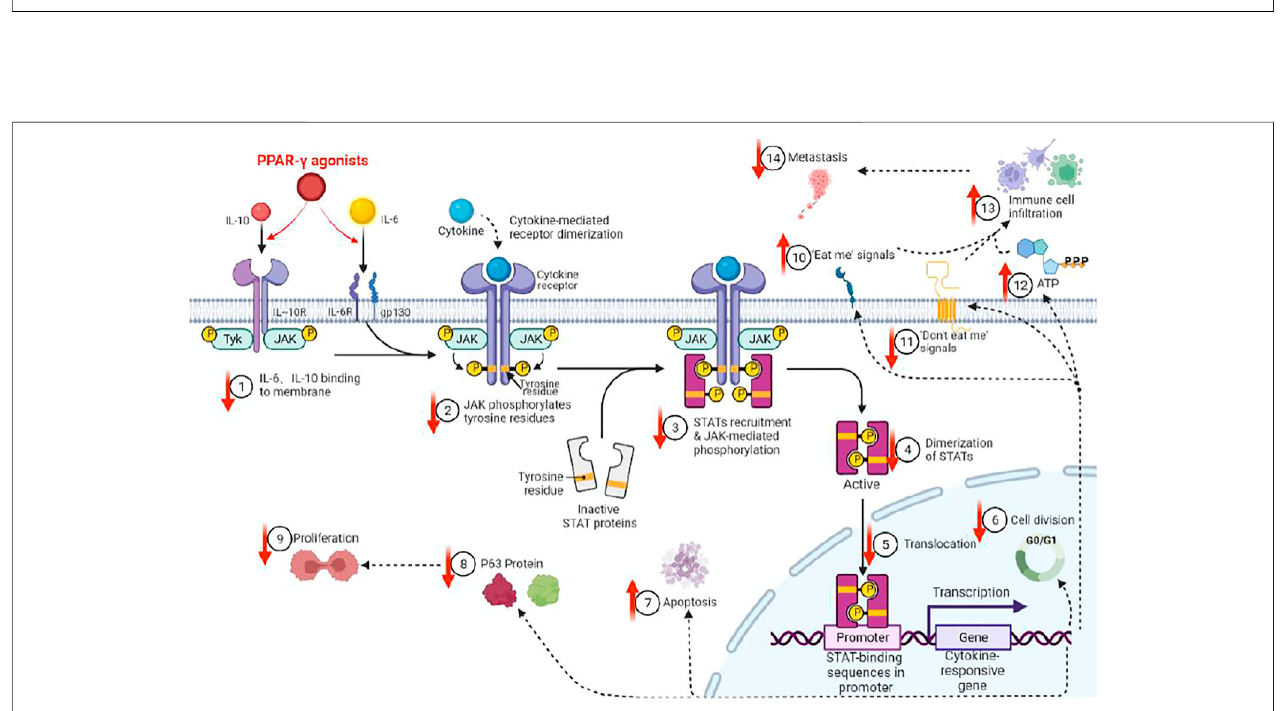
FIGURE 3 | Regulation of p63 isoforms. P63 is involved in modulation of the chromatin landscape in epidermal keratinocytes by directly regulating chromatin- modulating factors and engaging and opening chromatin regions. Multiple isoforms with distinct, often opposing, functions enable p63 to exert an array of effects on essential cellular functions.